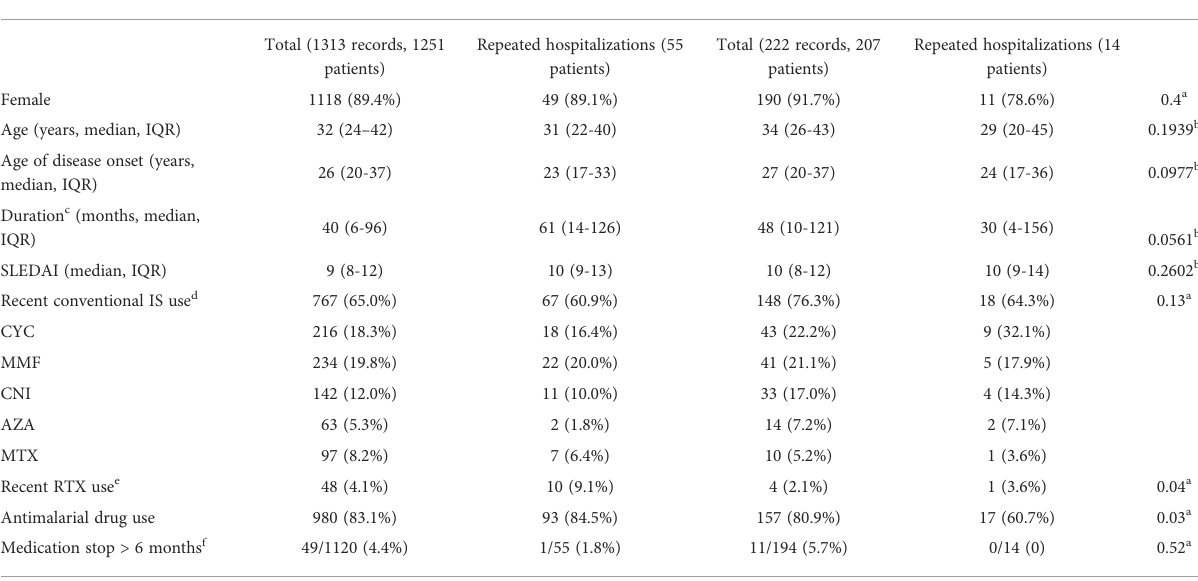
TABLE 1 Demographic and clinical features of the